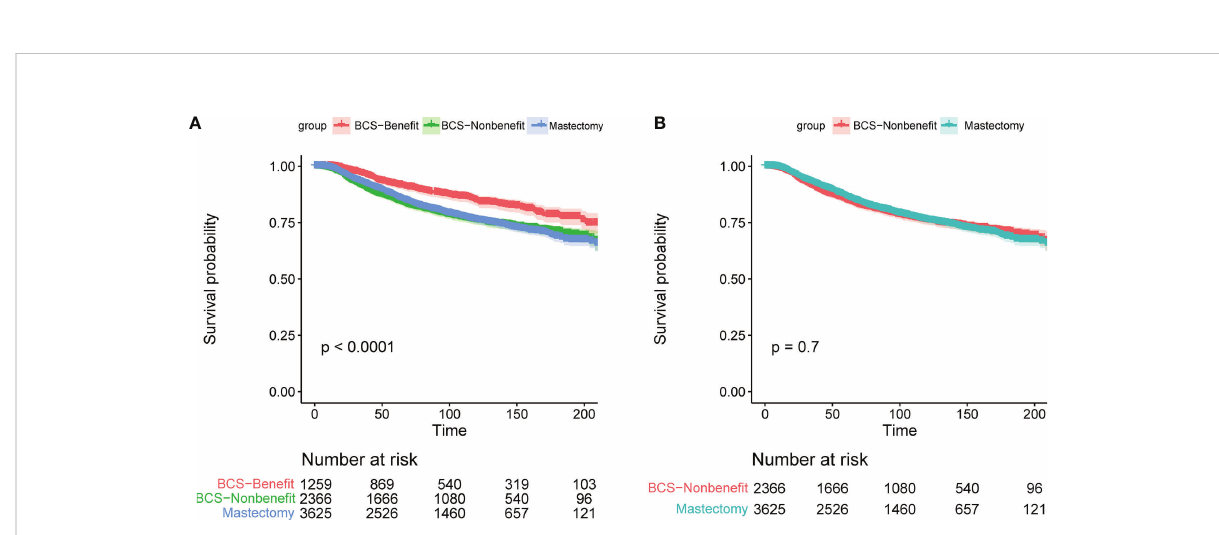
FIGURE 8 The KM survival analysis of patients in the BCS-Bene fi t group, BCS-Nonbene fi t group, and mastectomy group.